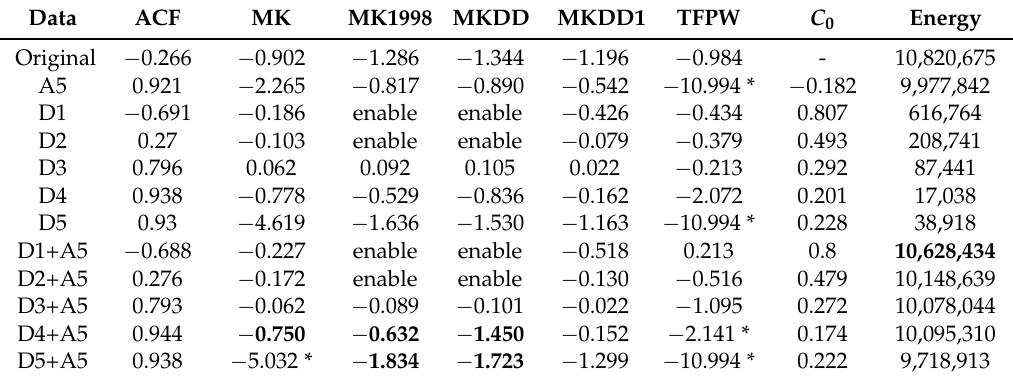
Table 9. Lag-one ACFs, Mann-Kendall values and energy of annual total precipitation: original data, detail components (D1–D5), approximations (A5) and a set of combinations of the details and their respective approximations. C 0 is the correlation coefficients between the decomposition combinations and the original